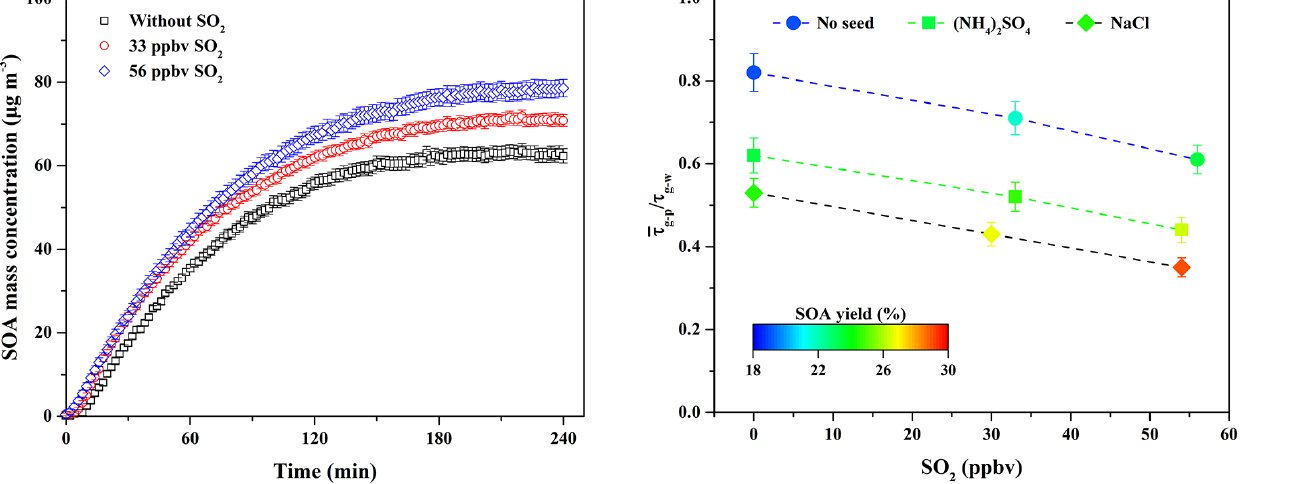
Figure 2. Time-dependent growth curves of SOA mass concentra- tion for guaiacol photooxidation at different SO 2 levels (Exps. 1–3 in Table 2).